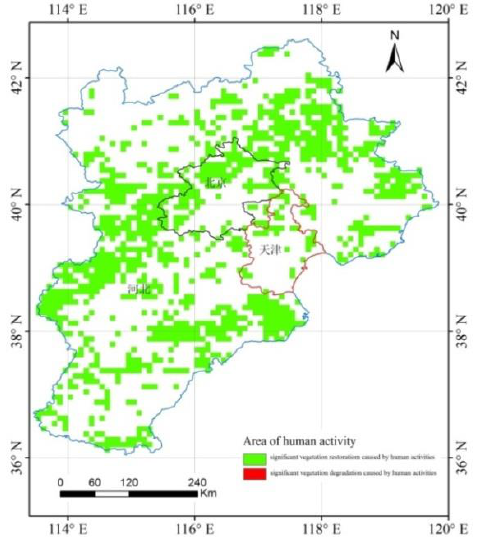
Figure 5 Distribution of the influence of human activities on vegetation changes in the Beijing-Tianjin-Hebei